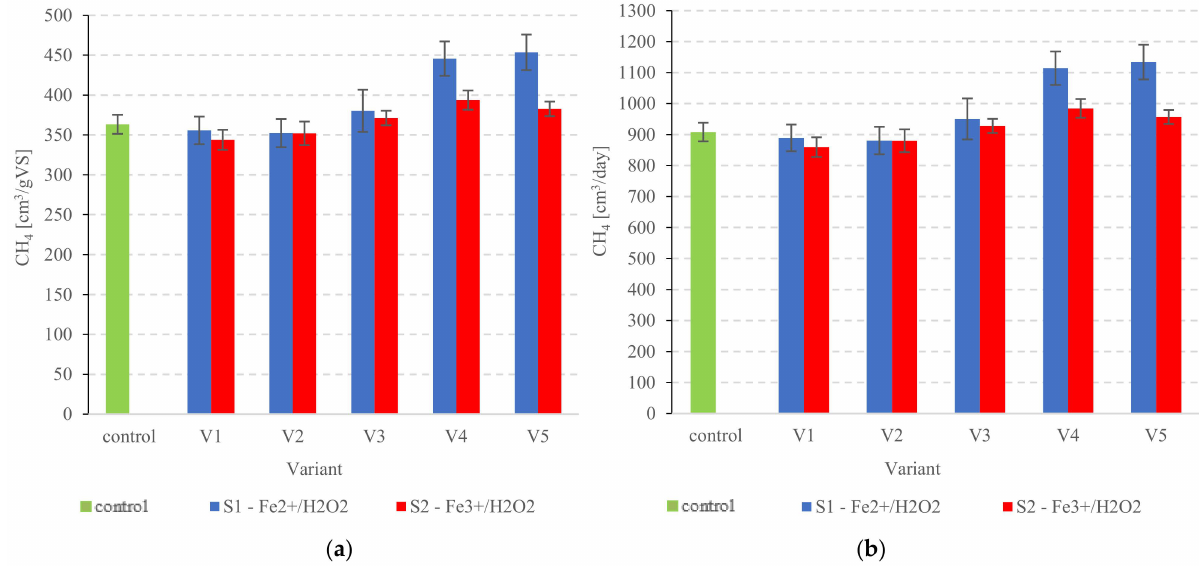
Figure 6. CH 4 production ( a ) from pre-treated PSS, ( b )